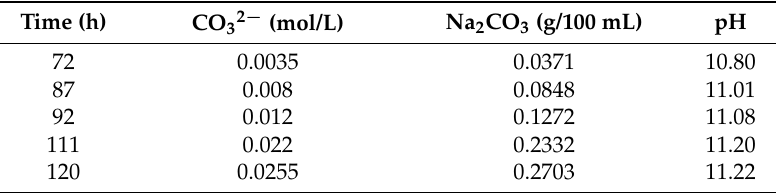
Table 1. pH of the Na 2 CO 3 solution from 72 h to 120 h.